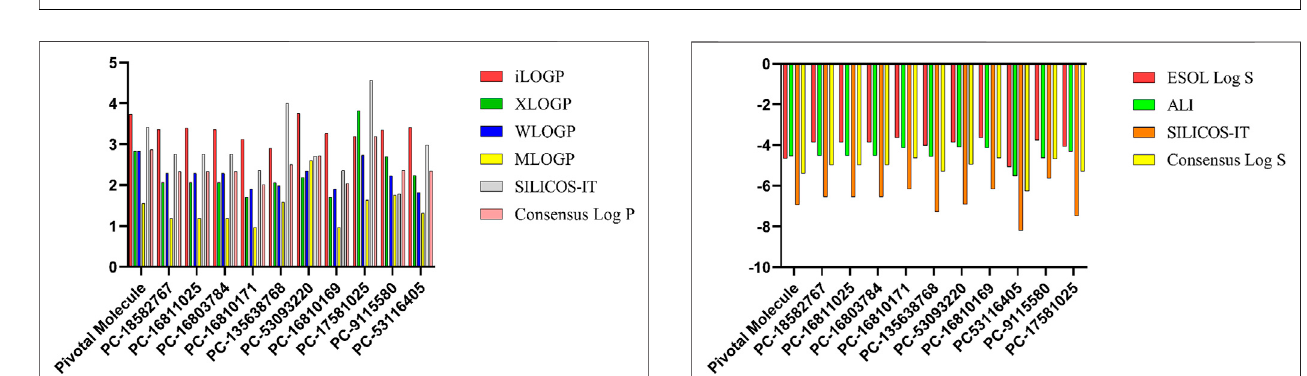
FIGURE 10 | Representation of 2D structures of 10 promising compounds obtained by hierarchical virtual screening. PC: PubChem.